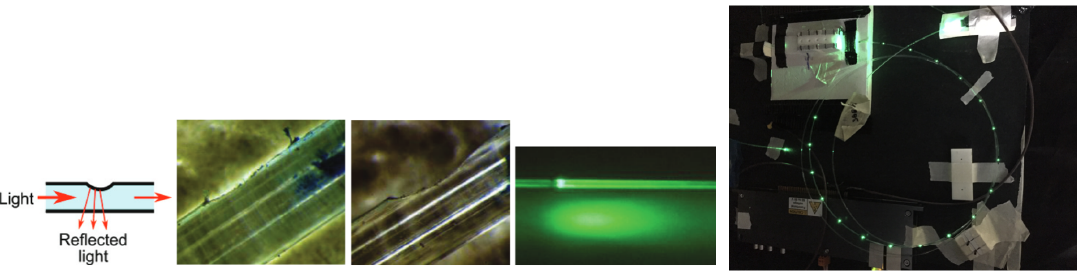
Figure 125. ( Left ): the notches made on a fiber are shown as well as its working principle. This figure is taken from [137]. ( Right ): a notched fiber illuminated with LED light is shown. The light exiting from each single notch is